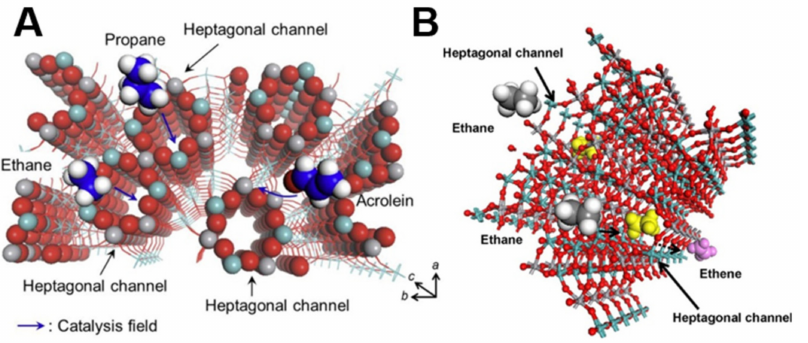
Figure 11. The heptagonal channel in the MoV catalysts for the selective oxidation of light alka- nes. ( A ) Propane and ( B ) Ethane. Adapted from refs. [88,90], Copyright (2014), with permission from